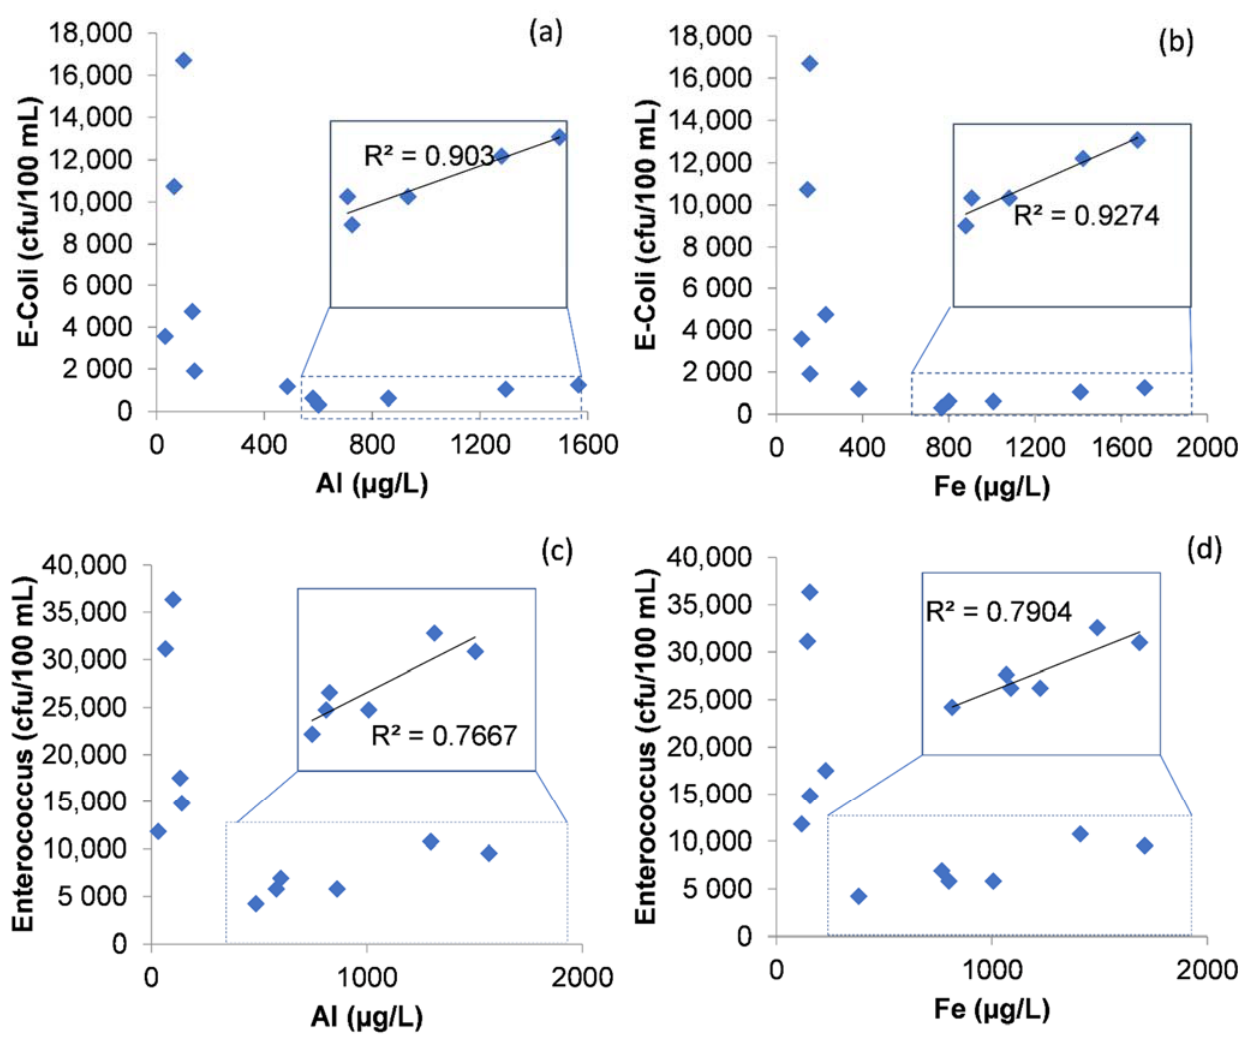
Figure 5. Relationship between metal ions and E. coli ( a , b ) and Enterococci spp. ( c , d ).